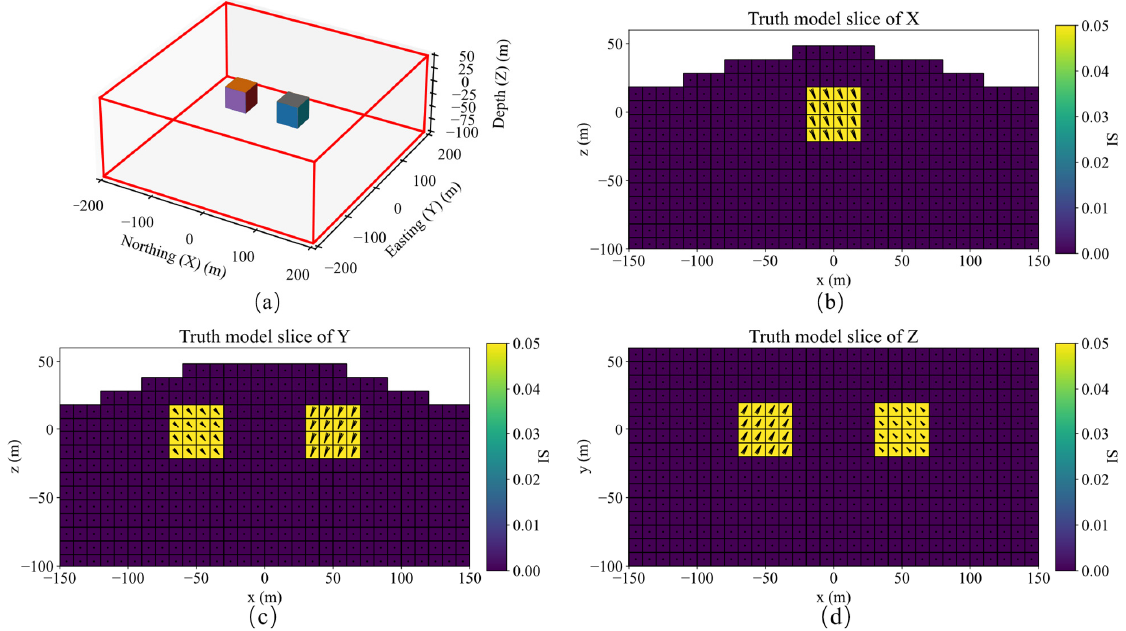
Figure 9. ( a ) Schematic diagram of dual models; slices of magnetization vector dual models along the X ( b ), Y ( c ), and Z ( d ) directions.